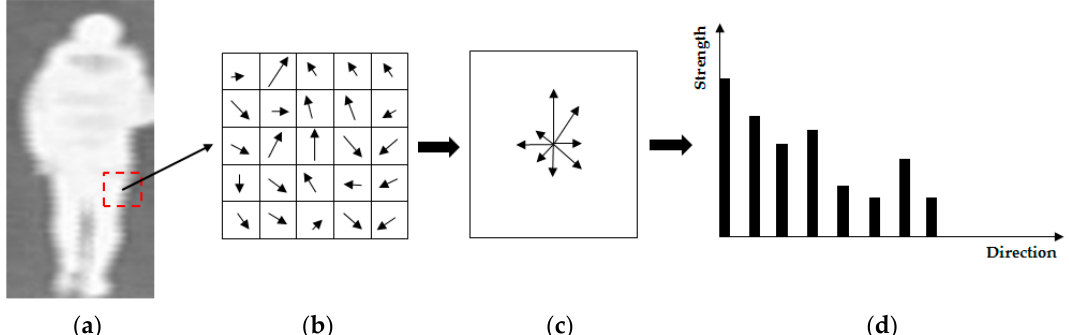
Figure 2. A demostration of the HOG feature extraction method: ( a ) the input image; ( b ) gradient map with gradient strength and direction of a sub-block of the input image; ( c ) accumulated gradient orientation; and ( d ) histogram of oriented gradients.